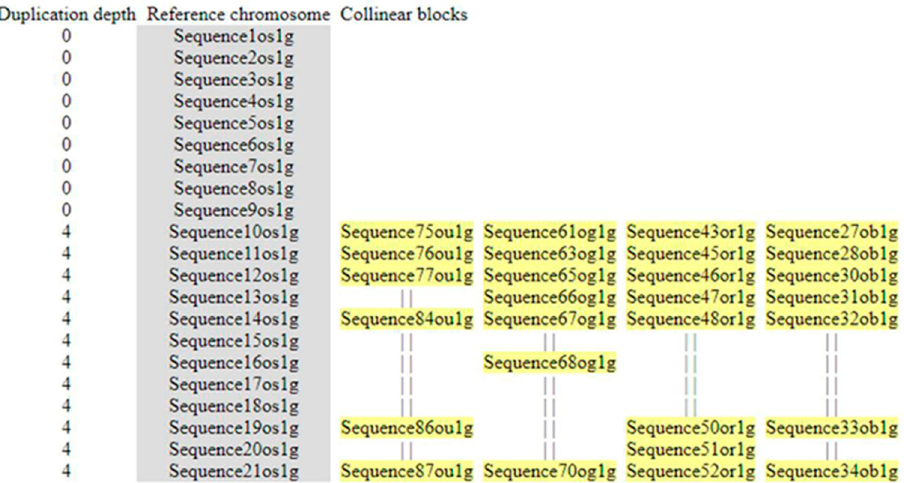
Figure 7. Diagrammatic representation of microsynteny analysis of 100 kb genomic segments flanking MIR408 across different poaceae members. Synteny block diagram for MIR408 with O. sativa as reference. The first column shows duplication depth at each gene locus; the second column shows the genes in reference chromosomes, and the following ones show aligned collinear blocks where only match genes are displayed. The alignment among non-anchor genes was discarded in the output and was simply denoted with “||” in the multi-alignment of gene orders.